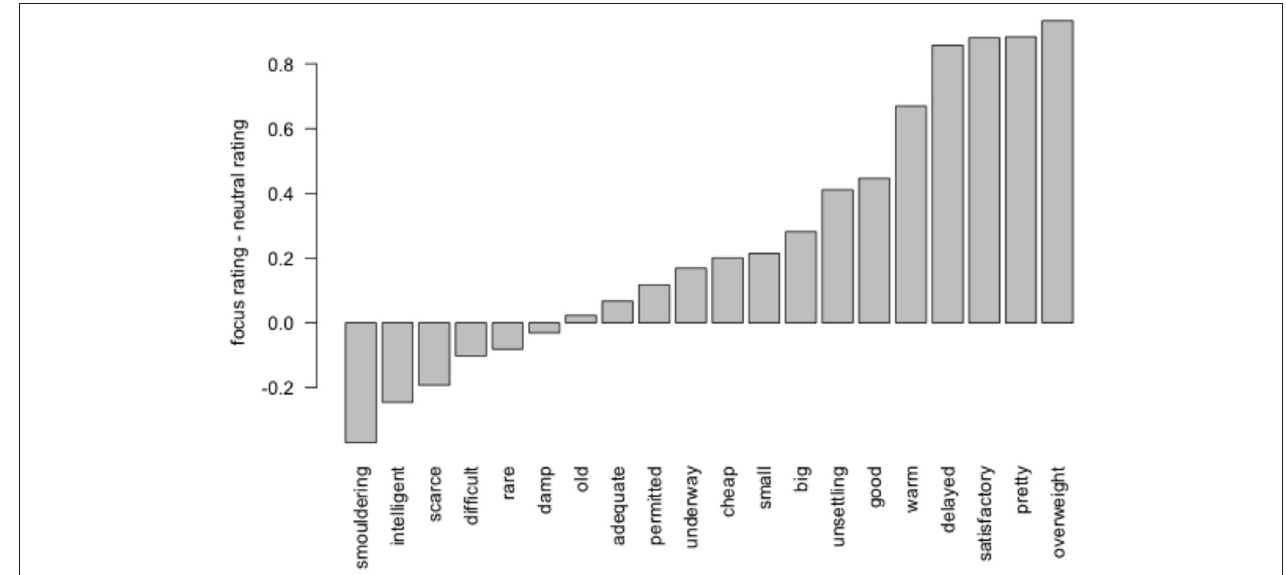
FIGURE 1 | Endorsement of pragmatic meaning for weak scalars in Experiment 1, by